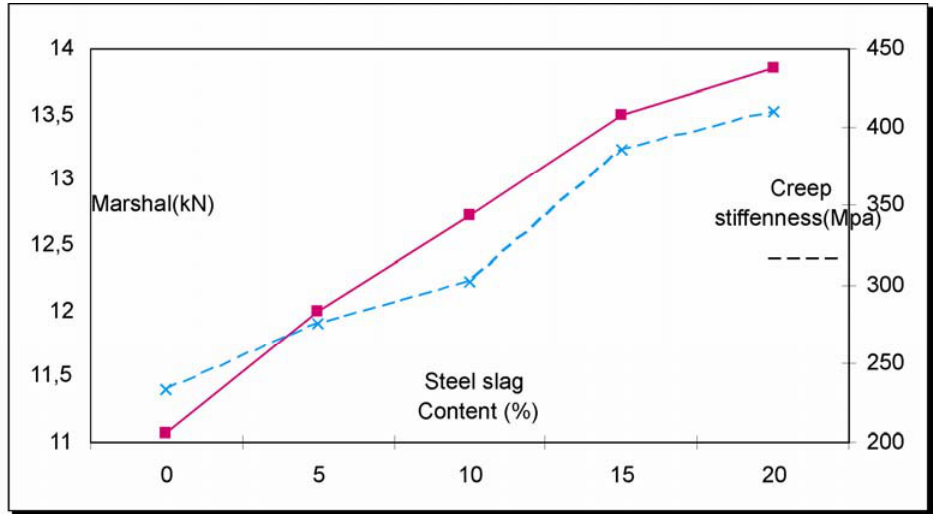
Fig 3. Marshall stability and creep stiffness as functions of different steel slag